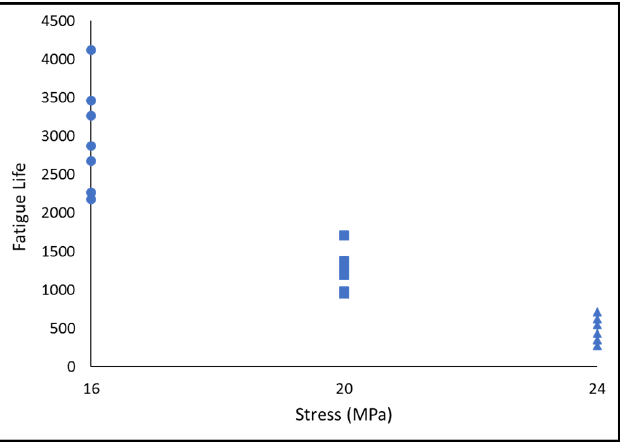
Figure 8. The fatigue life of SAC305 solder joints as a function of stress amplitude.